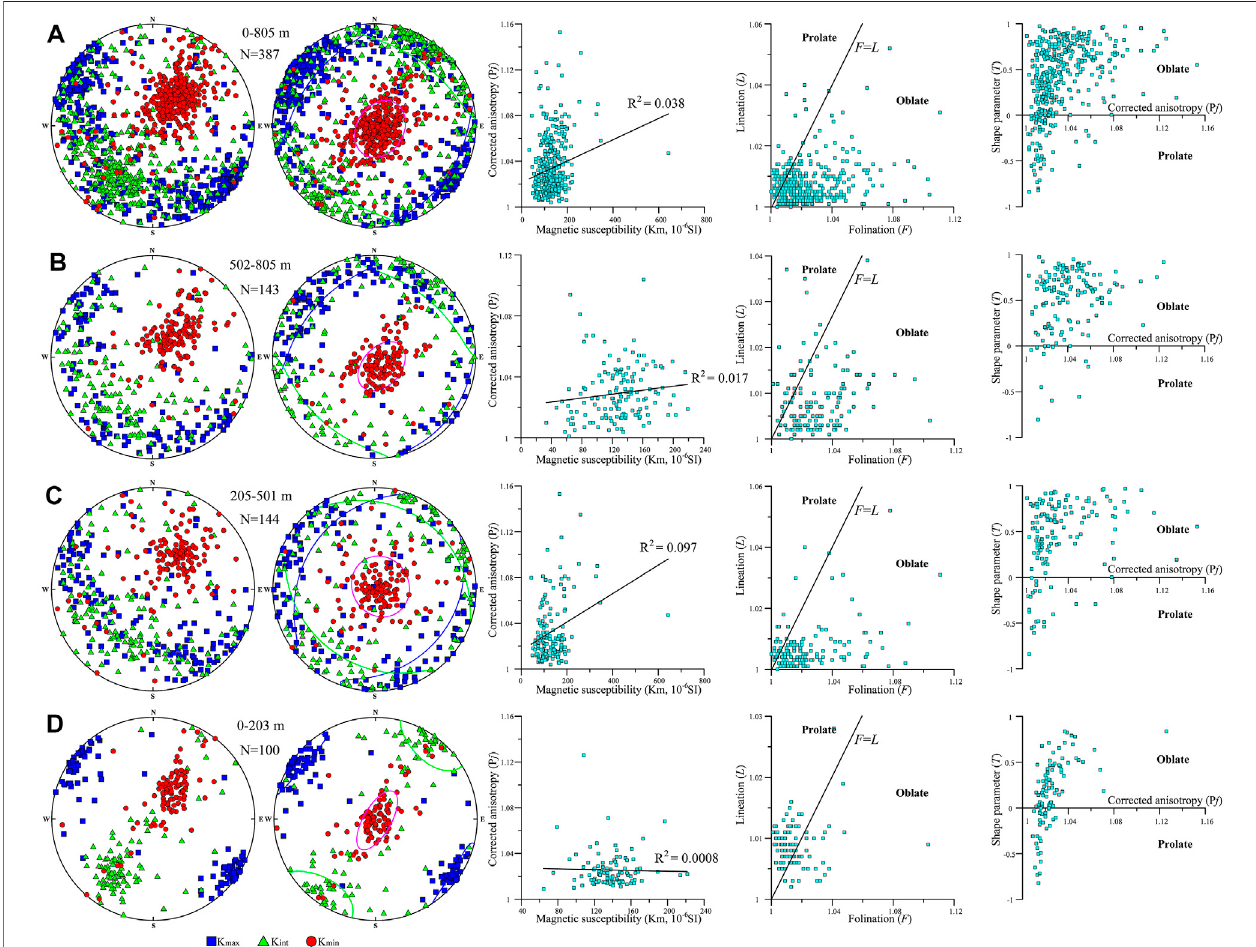
FIGURE 3 | AMS results including equal-area stereographic projections of the AMS principal axes in both in situ and bedding-corrected coordinates (squares, trianglesandcirclesrepresentK max ,K int ,andK min axes,respectively),themeanmagneticsusceptibility(Km)versuscorrectedanisotropy(Pj),foliation(F)versuslineation (L)plots,andPj-Tdiagrams)ofthetotalsamples (A) ,samplesfrom502to805 m (B) ,samplesfrom205to501 m (C) andsamplesfrom0 – 203 m (D) alongtheQigequan pro fi